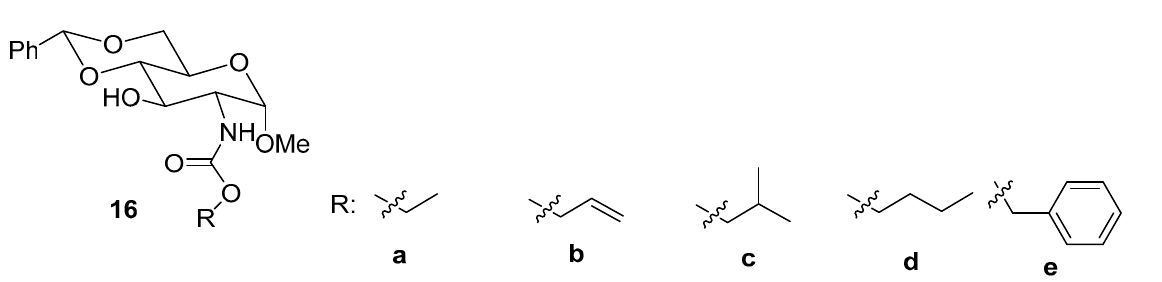
Figure 9. Structures of carbamate derivatives of 4,6-O-benzylidene-methyl-a-D-glucosamine [34].